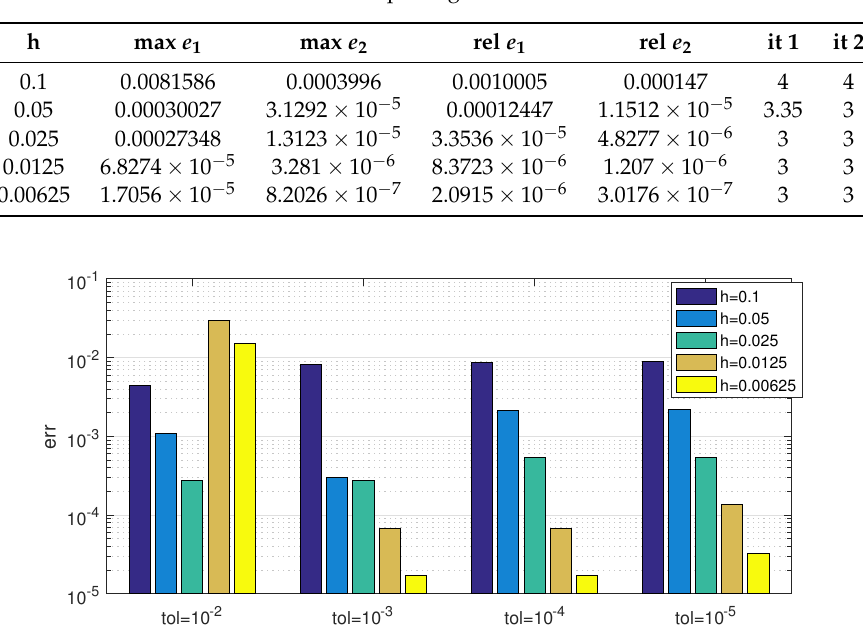
Figure 1. Matrix problem. Precision of the modern version of the multi-splitting iterative approach in terms of the time step h and the